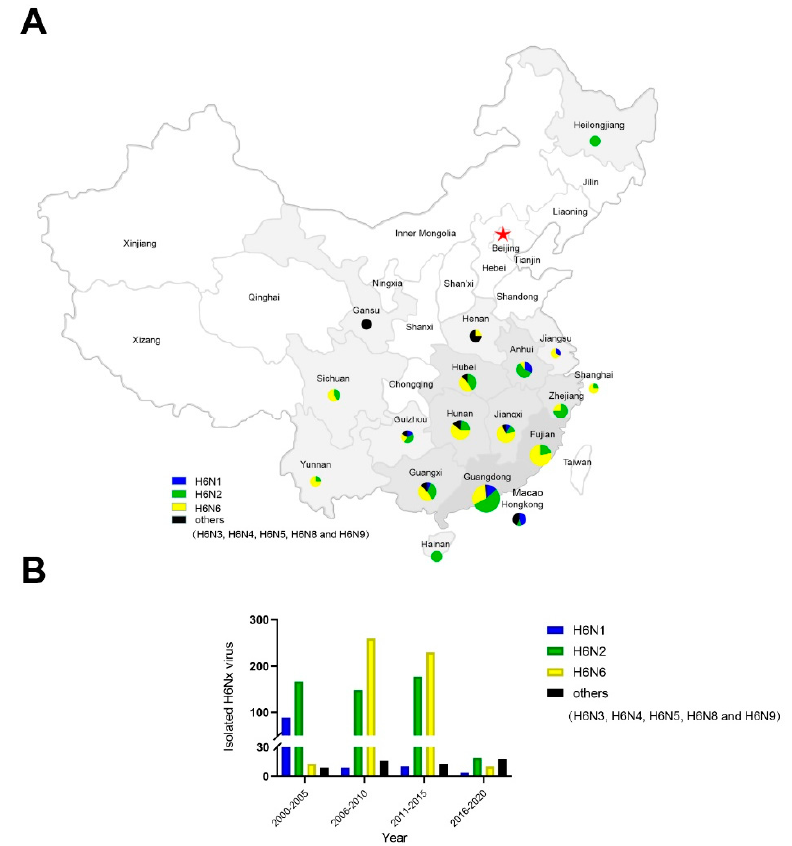
Figure 1. Geographic distribution of H6 subtype influenza viruses in China. ( A ) Distribution of H6Nx influenza viruses in China. In the pie charts, the size represents the number of H6 subtype influenza viruses and the colors represents H6 subtype viruses embodying different neuraminidases. The different background between provinces is indicated by the gray background color as areas isolated to the H6 subtype virus, while the white color indicates none. ( B ) The isolation rate of H6Nx influenza viruses isolated from China. Data are available from the GISAID’s EpiFlu Database and GenBank Database. The map was designed using ArcGIS Desktop 10.4 software.